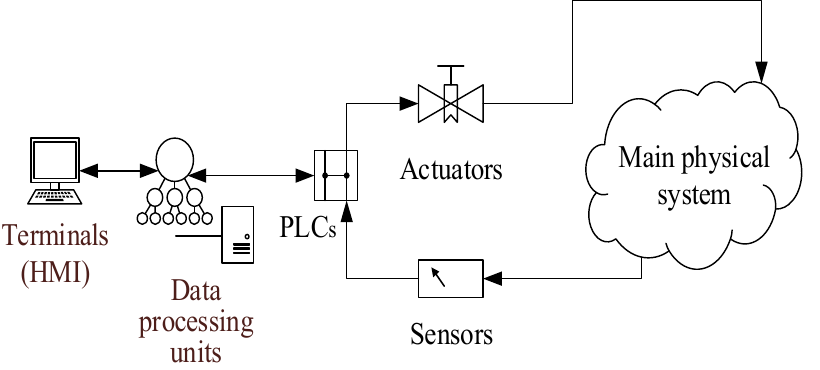
Figure 1. A sketch of the main components of an I&C system.